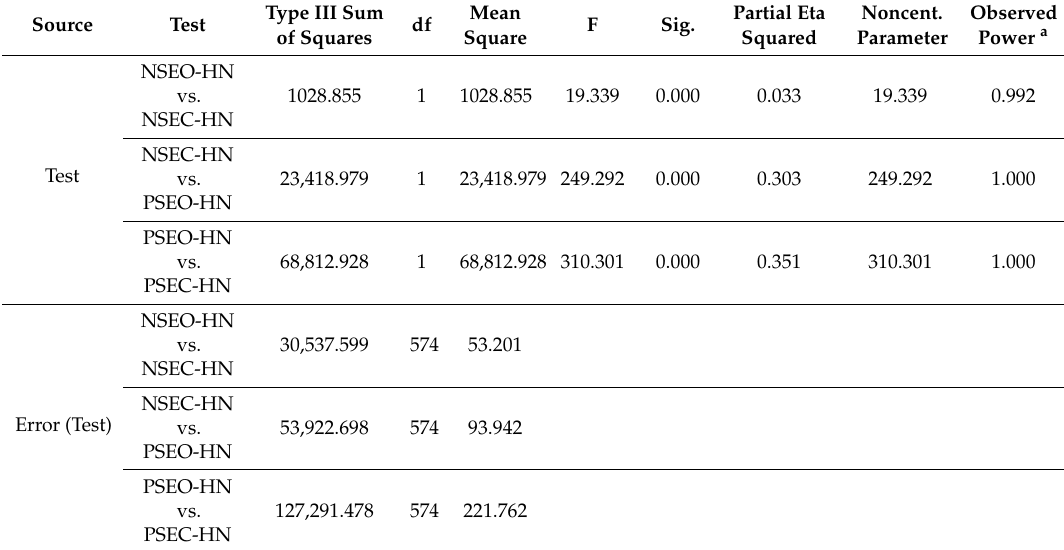
Table 7. Tests of within-Subjects Contrasts for Concussion Patients’ Postural Stability Scores Head Neutral mCTSIB.